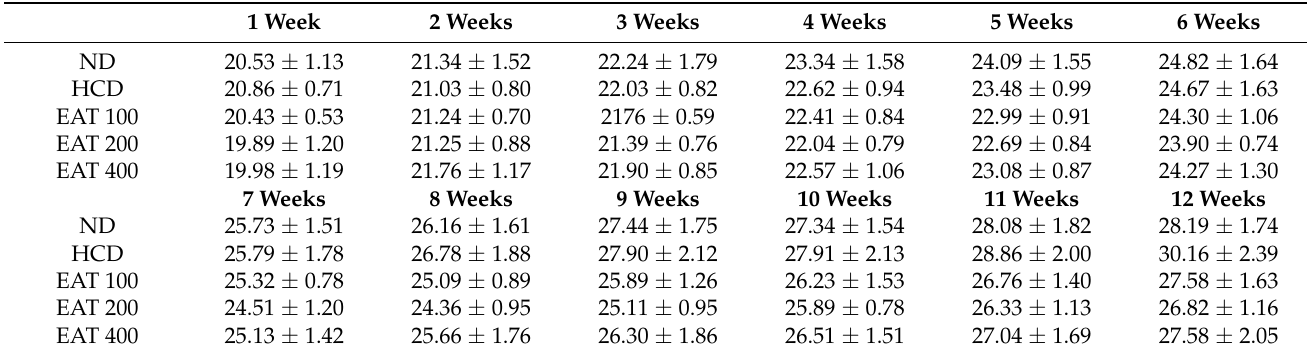
Table 2. Effect of ethanol extract of Amomum tsao-ko (EAT) on body-weight change in a high-carbohydrate diet (HCD)- induced C57BL/6 mouse model.